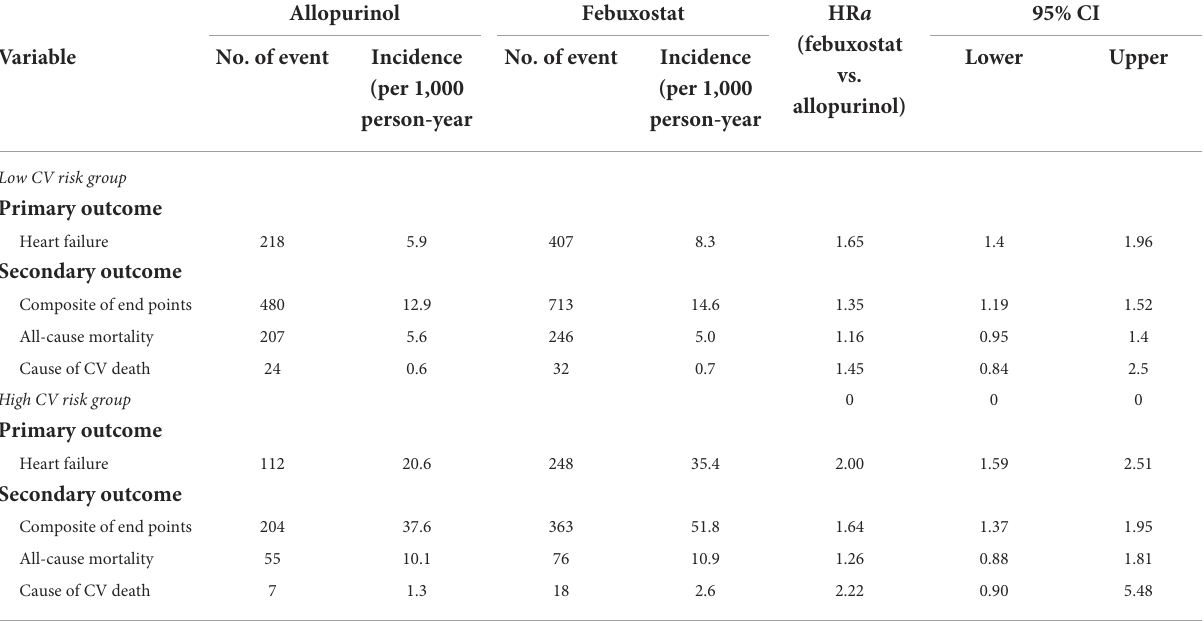
TABLE 3 Heart failure, composite of end points, all-cause mortality, and cause of CV death between patients taking allopurinol and febuxostat for more than 1-year. Allopurinol Febuxostat